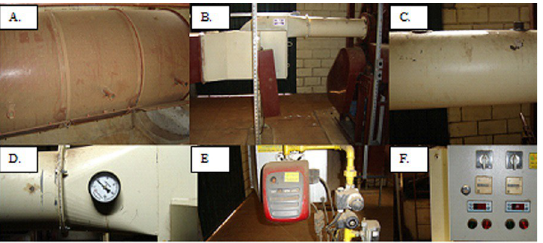
Fig 1. Horizontal rotary dryer (A), centrifugal fan (B), measurement of the fan outlet air temperature and dryer inlet (C), manometer to measure the air pressure exerted by the fan (D), inlet energy system (gas) and burner (E), control panel